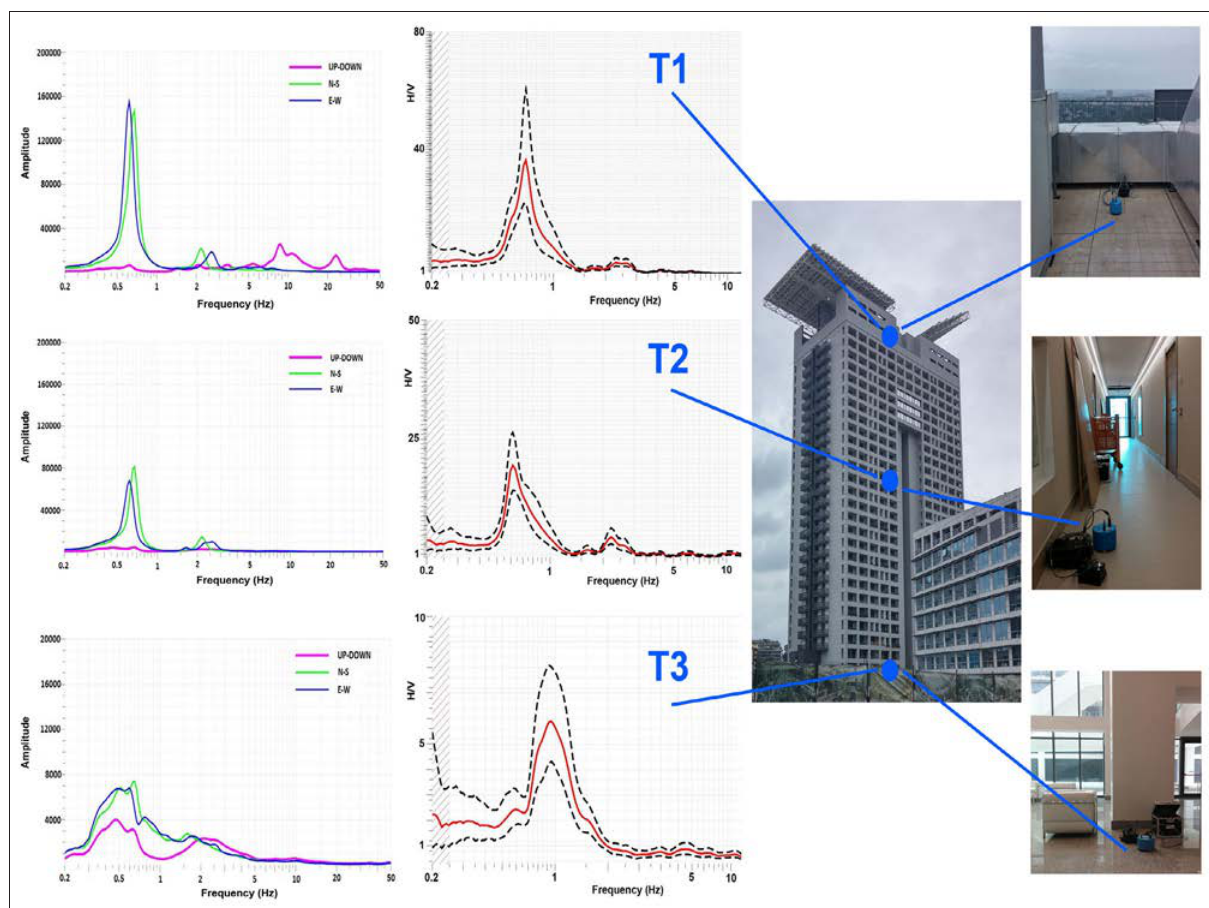
Figure 9. Results of noise measurements (Fourier Spectra and H/V) performed on the north Eurosky tower. T1: roof; T2: middle floor; T3: ground floor. Note the attenuation of the peak amplitude from the top of the tower to the bottom and the shift of the peak frequency from the vibration mode of the tower (T1 and T2) to the site main vibration (T3). Red line: average H/V spectral ratio; dashed black lines: standard deviation of the H/V spectral ratio; dotted zone: unreliable frequency range of the H/V spectral